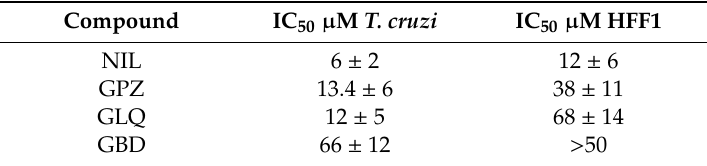
Table 4. Half maximal inhibitory concentration of potential Tc DHFR-TS inhibitors against T. cruzi and